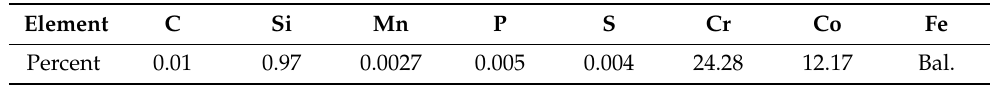
Table 2. Mechanical properties of Fe-Cr-Co permanent magnet alloy.